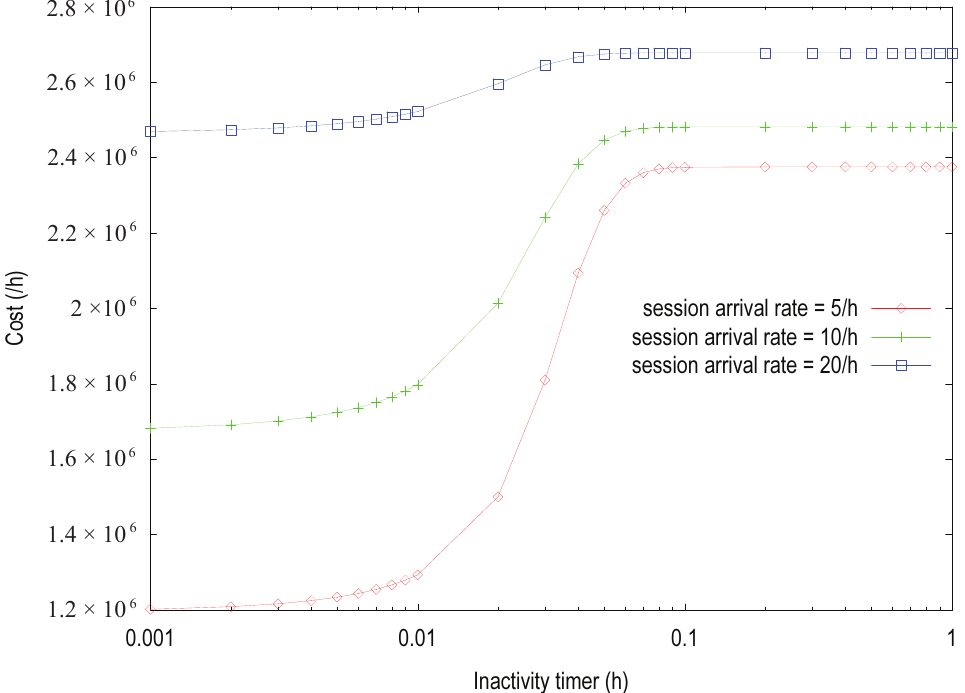
Figure 8. Cost by varying session the arrival rate (small values of T